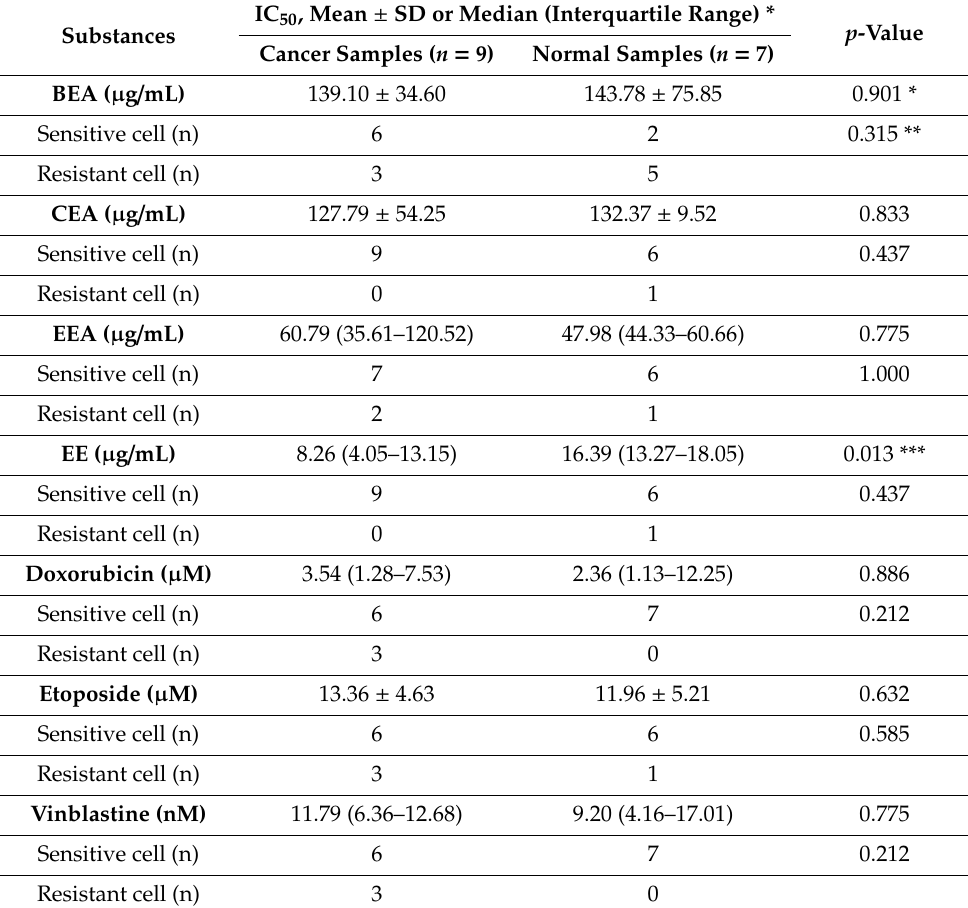
Table 8. IC 50 of each substance (extracts or drugs) and p -value compared the IC 50 or sample number between lung cancer samples and normal lung samples.